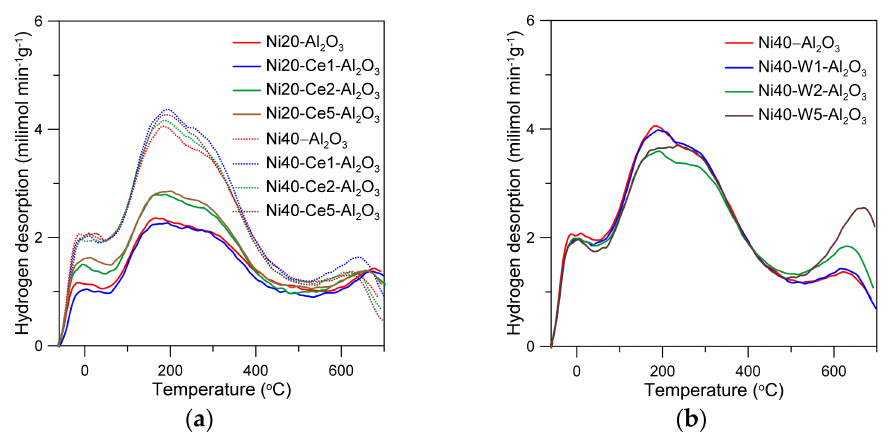
Figure 7. Temperature-programmed desorption of hydrogen from the Ce- and W-promoted nickel catalysts ( a , b